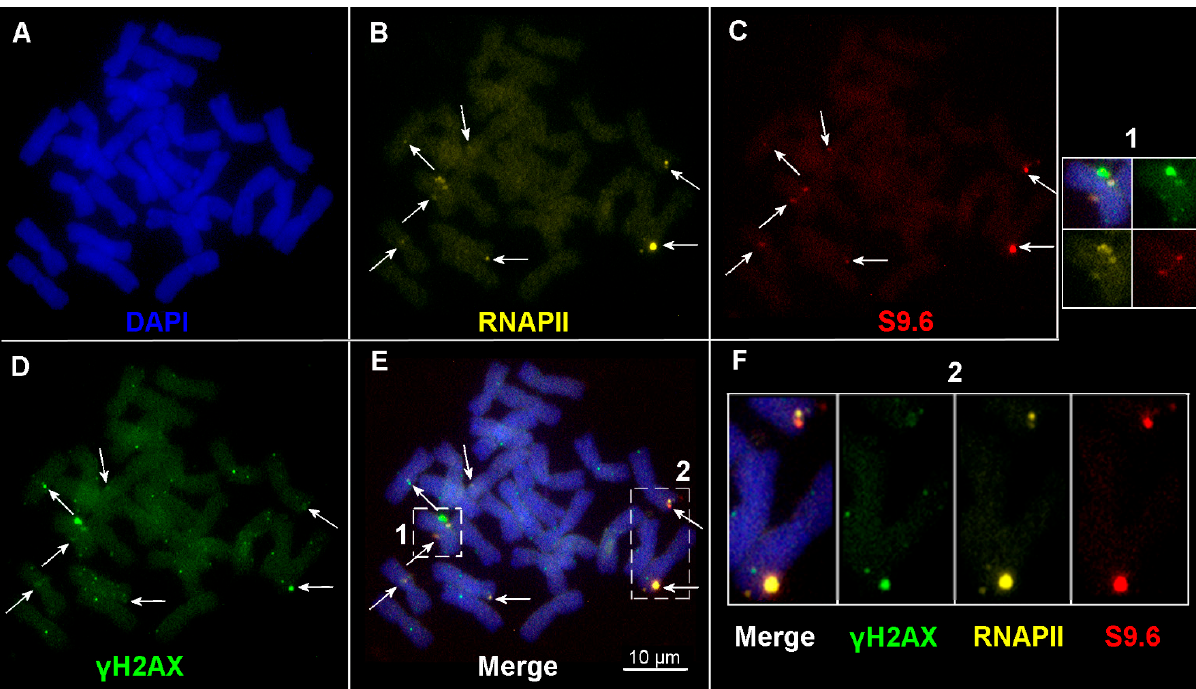
Figure 5. Immunodetection of clusters of RNAPII, S9.6, and γ H2AX on metaphase chromosomes; genotype B81. ( A ) Counterstaining with DAPI. Immunofluorescent localization of ( B ) anti-RNAPII Alexa Fluor ® 546-conjugated antibody (in yellow), ( C ) anti-DNA-RNA hybrid [S9.6] FluoroProbes ® 647-conjugated (in red) antibody, ( D ) anti- γ H2AX antibody; anti-rabbit Alexa Fluor ® 488-conjugated secondary antibody (in green). ( E ) Merged image. ( F ) The fragments in dashed boxes 1 and 2 in ( E ) are shown as enlargements in small boxes. The seven co-localized clusters of RNAPII, S9.6, and γ H2AX are indicated by arrows. Bar represents 10 µm.